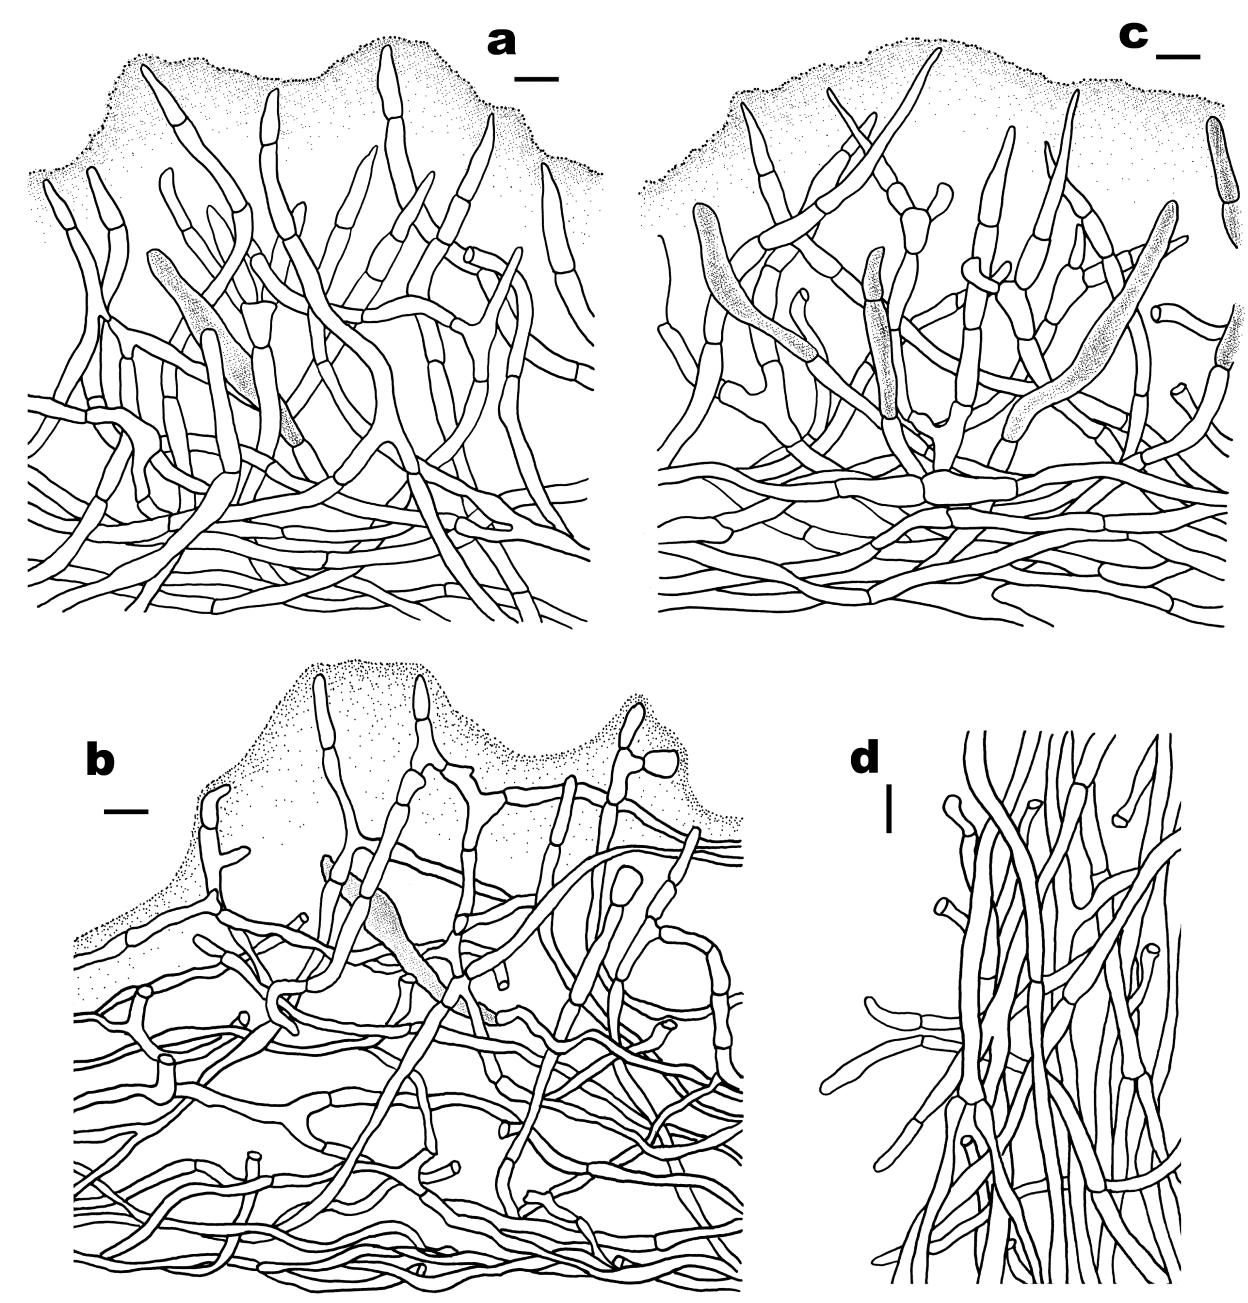
Figure 7. Microscopic features of Russula oraria (FHMU5355, holotype). ( a ) Pileipellis at pileus margin. ( b ) Pileipellis at middle part between center and margin of pileus. ( c ) Pileipellis at pileus centre. ( d ) Stipitipellis. Bars: 10 μm. Drawings by Y.X. Han. Description — Basidiomata small-sized. Pileus 3.5–4 cm diameter, broadly convex to Russula rufobasalis Y. Song and L.H. Qiu, Cryptog. Mycol. 39 (3): 352, 2018 (Figures applanate, center slightly depressed, margin occasionally cracked; surface dry, white (2A1), 2e,f, 3e,f, 8 and 9). pale yellow (3B2) to pale yellowish-brown (1B4) at center, margin with obvious radial tuberculate-striate; context about 2 mm thick at the center of the pileus, white